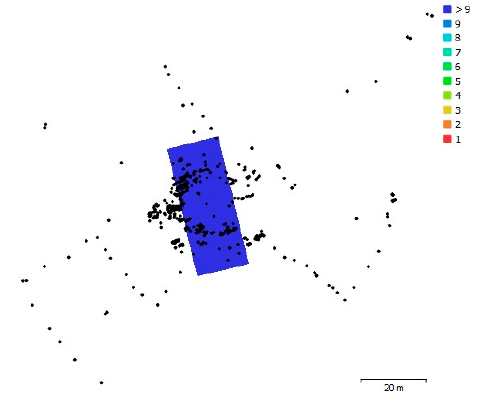
Figure 5. Camera locations and image overlap.